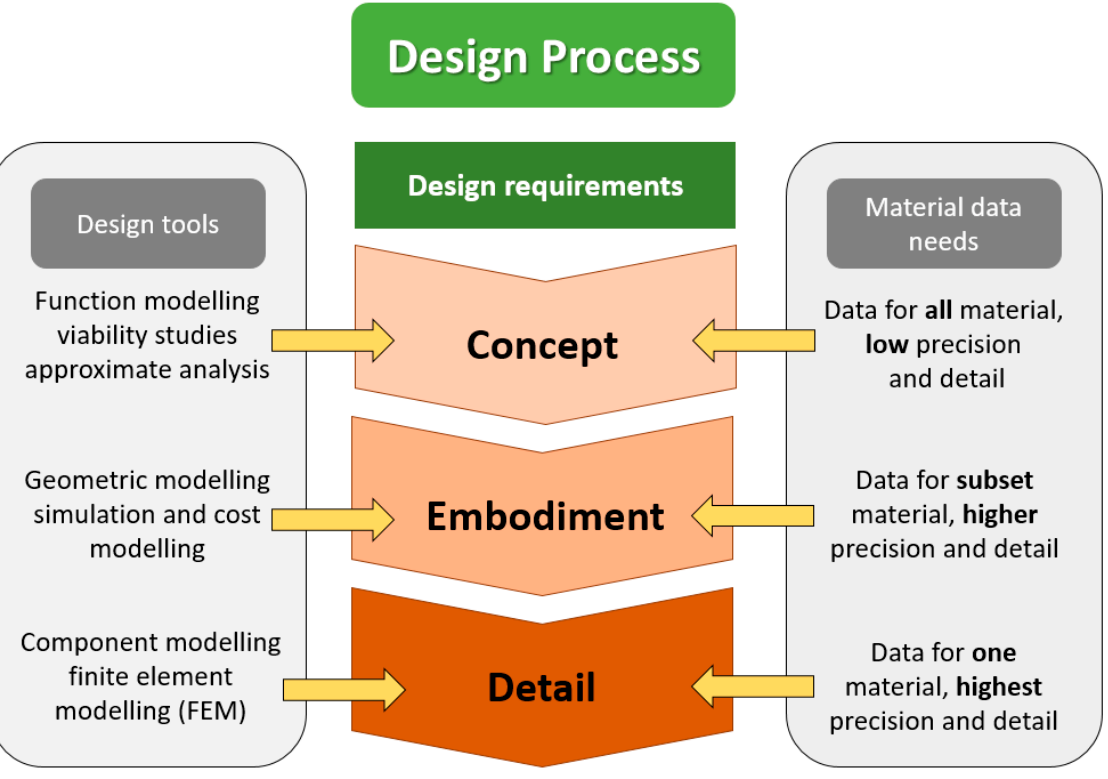
Figure 3. The design process in concurrent engineering.